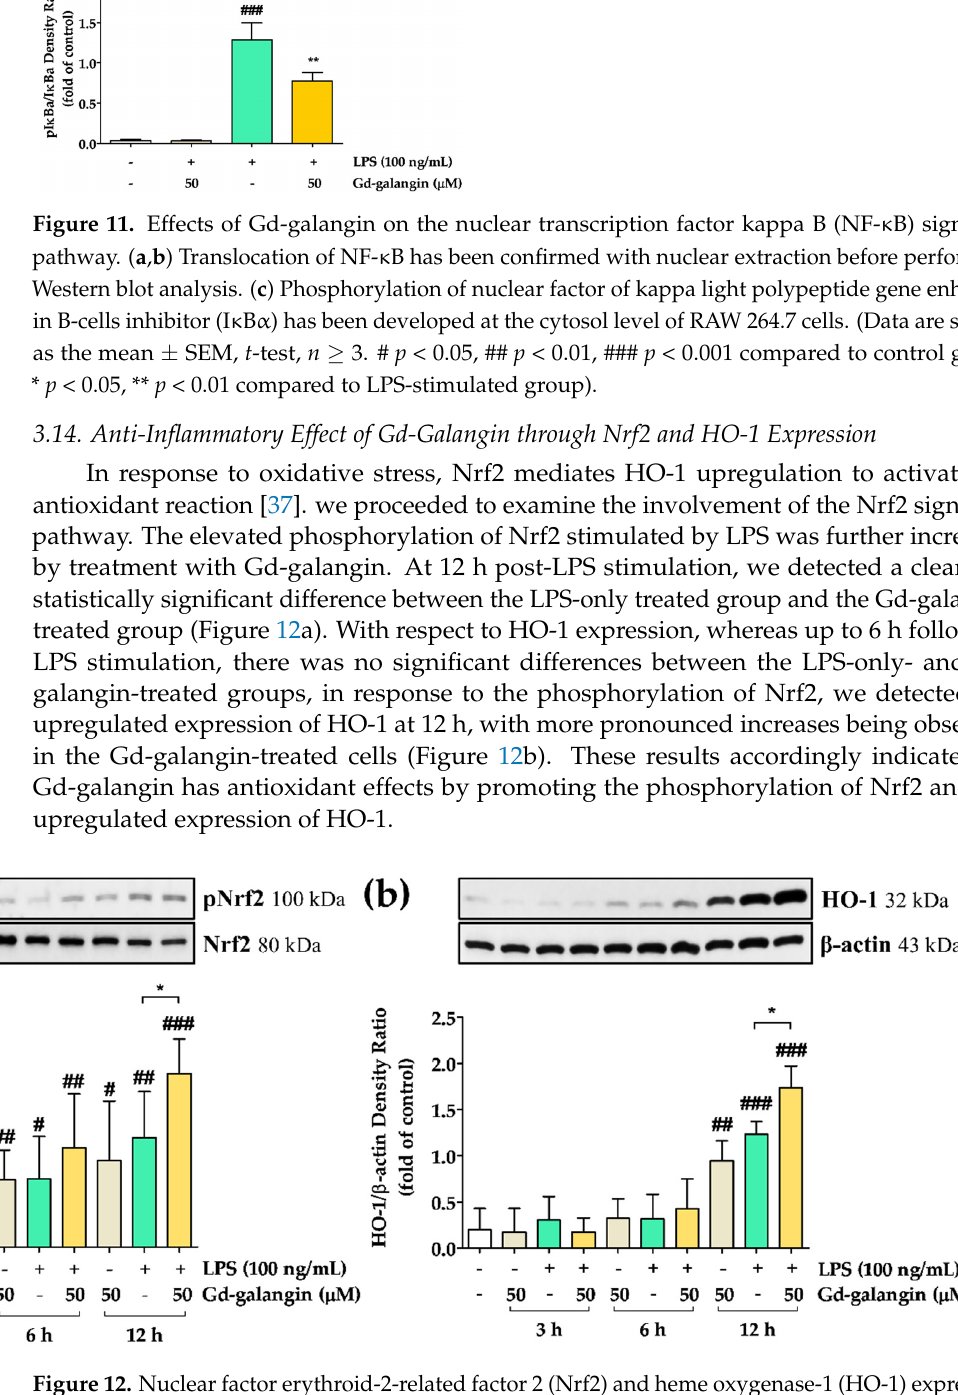
Figure 12. Nuclear factor erythroid-2-related factor 2 (Nrf2) and heme oxygenase-1 ( HO-1) ex- pression at the protein level in the RAW 264.7 cells. ( a ) Gd-galangin showed upregulation of phos- phorylated Nrf2. ( b ) HO-1 was upregulated following phosphorylation of Nrf2 by Gd-galangin. The expression of Nrf2 and HO-1 was identified with Western blot analysis. Data are shown as the mean ± SEM, t -test, n ≥ 3. # p < 0.05, ## p < 0.01, ### p < 0.001 compared to control group; * p < 0.05